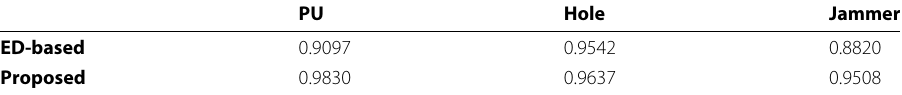
Table 5 AUROC values for jamming attack PU Hole Jammer ED-based